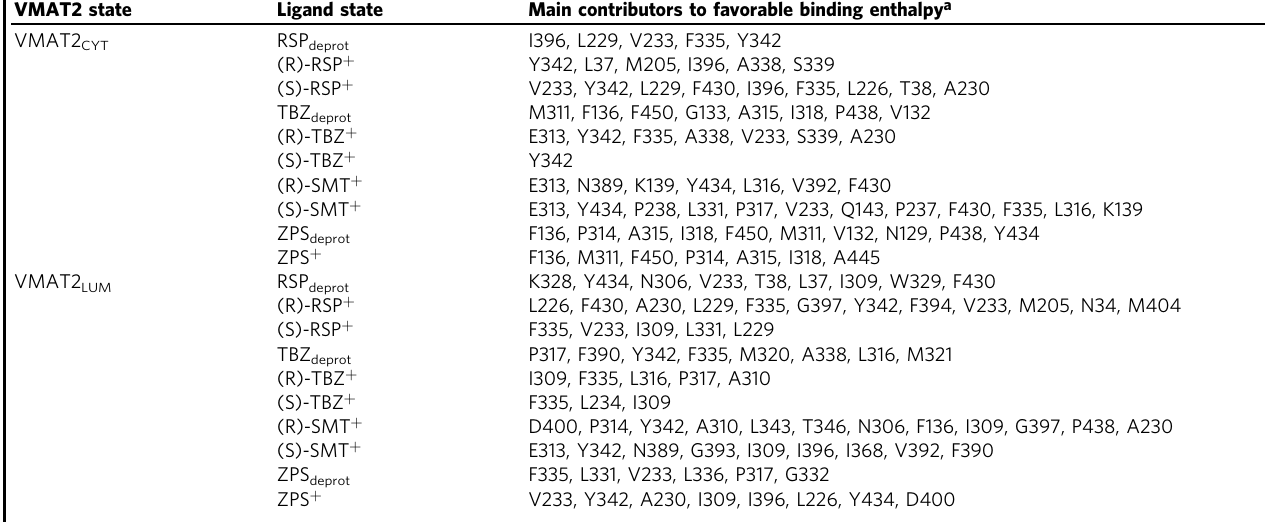
Table 2 MM/GBSA per residue